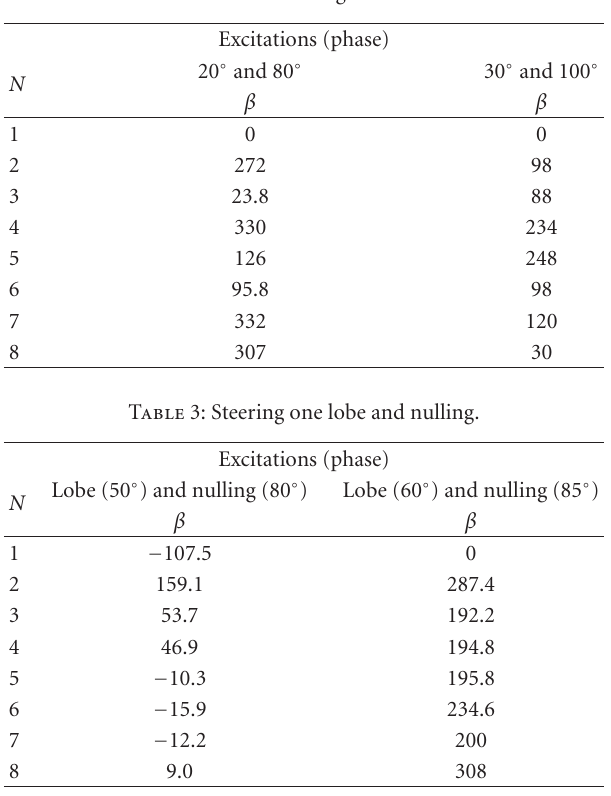
Table 2: Steering 2 lobes.